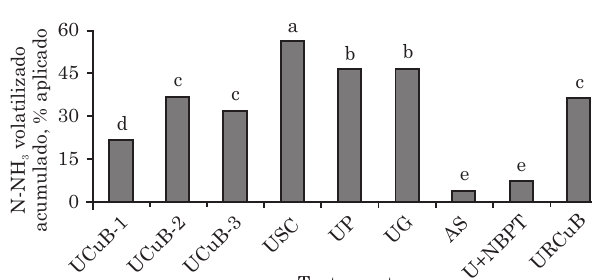
Figura 3. Perdas acumuladas por volatilização de N- NH 3 provenientes dos fertilizantes pastilhados de ureia com micronutrientes após 18 dias de avaliação, em que: UCuB-1 (ureia pastilhada com Cu e B, 38,8 % N; 0,5 % Cu; e 2,0 % B), UCuB-2 (ureia pastilhada com Cu e B, 40,08 % N; 2,0 % Cu; e 0,5 % B), UCuB-3 (ureia pastilhada com Cu e B, 42,78 % N; 0,5 % Cu; e 0,5 % B), USC (ureia pastilhada com sulfato de cálcio, 38,76 % N), UP (ureia pastilhada, 45,0 % N), UG (ureia granulada, 45,0 % N), U+NBPT (ureia contendo inibidor da urease NBPT, 45,0 % N), URCuB (ureia revestida com Cu e B, 44,08 % N; 0,06 % Cu e 0,3 % B) e AS (sulfato de amônio, 21,0 % N). Médias seguidas de letras distintas diferem entre si pelo teste de Scott-Knot a 5 %.